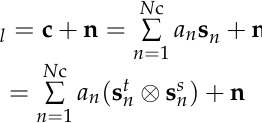
where c and n denote the clutter component and white Gaussian noise component, respec- tively. The Nc denotes the number of the clutter patch, which is evenly distributed in each clutter range ring. For the n − th clutter patch, a n is the complex amplitude and s is the n space-time steering vector. The azimuth and elevation angles corresponding to the n − th clutter patch are θ n and ϕ n , respectively. s is obtained by the Kronecker product of the n temporal steering vector s t and the spatial steering vector s s . Due to the presence of the n n acceleration, it is worth noting that the temporal steering vector is different from that of a conventional uniform motion radar, but the spatial steering vector is the same. Here, we give a brief explanation. First, we assume that a scattering point P is located on the l − th range gate and its direction vector can be expressed as: